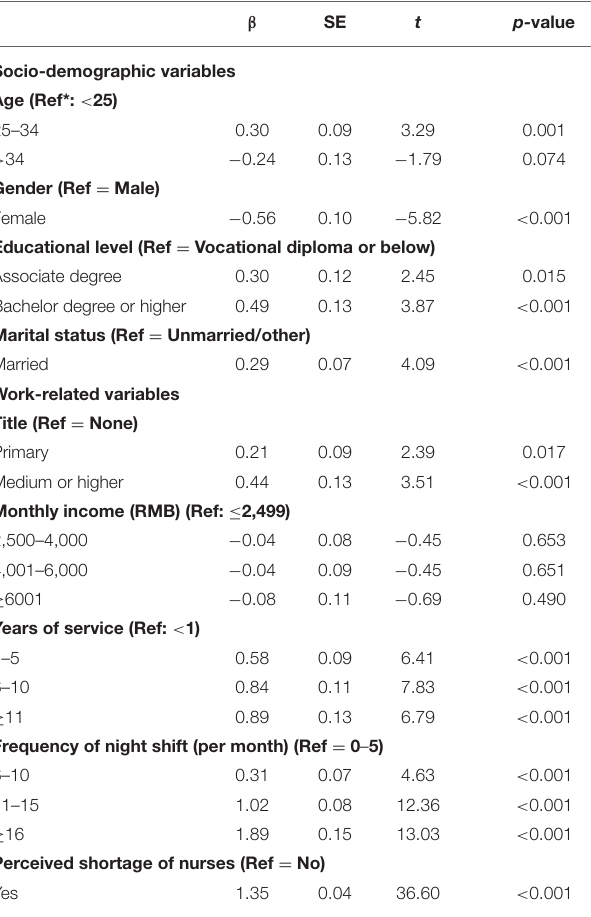
TABLE 1 | Univariate analysis of work-family conflict of emergency nurses ( n = 17,582).